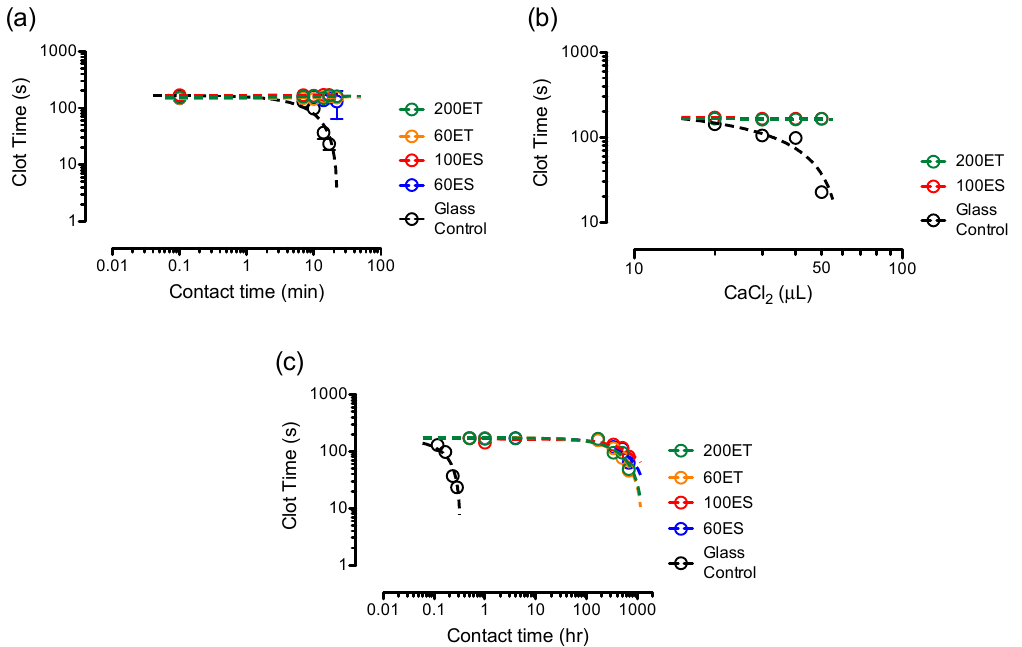
Figure 8. In vitro clotting assays on the various PU films in comparison with the glass control, showing ( a ) clotting assay (1) where human blood plasma were placed on the surface of the activating substances; ( b ) effects of CaCl 2 concentrations on the clot times using clotting assay (1); and ( c ) clotting assay (2) where human blood plasma and the activating substances were placed in an enclosure.